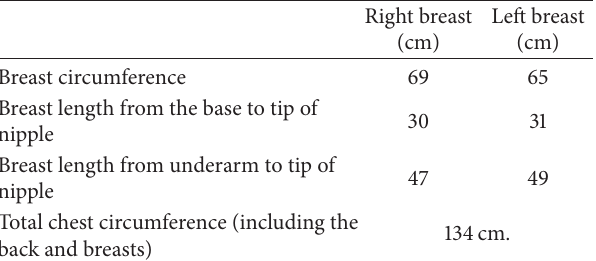
Table1:Breastdimensionsofpatientwithgestationalgigantomastia on 22/7/2014, postpartum day